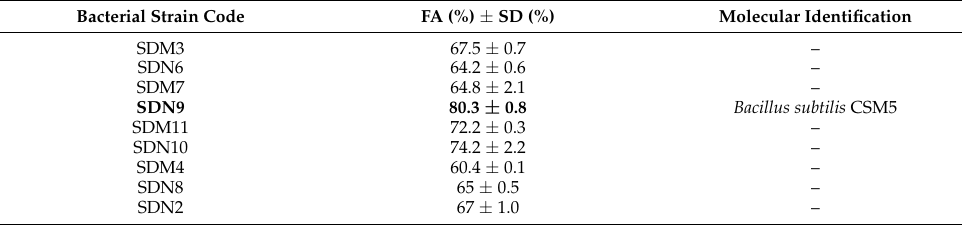
Table 1. Flocculating activity of the screened bacterial